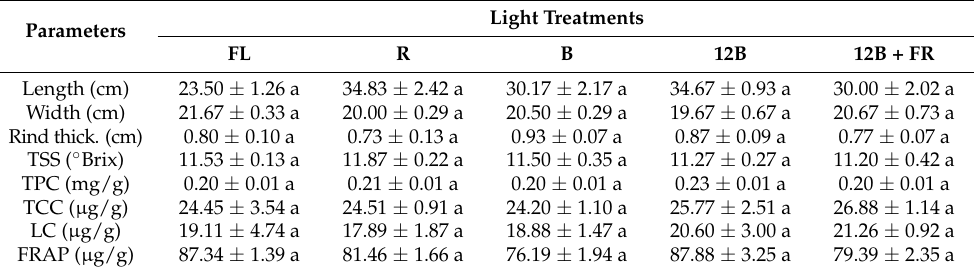
Table 2. Morphological and biochemical parameters of ripe watermelon fruits after field cultivation. The seedlings were treated for six days in a healing chamber with five light treatments. Mean values ( n = 3; ± SE) within a row followed by different letters are significantly different (a < 0.05).